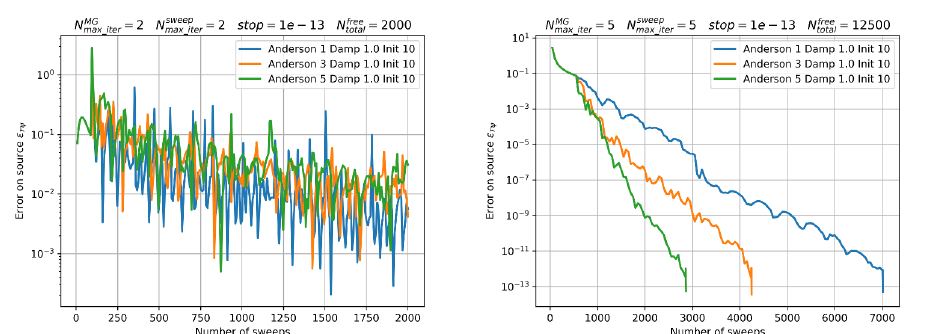
Figure 1: Convergence of the Anderson algorithm for inner loops with different number of maximum iterations but with same stopping criteria of 10 − 13